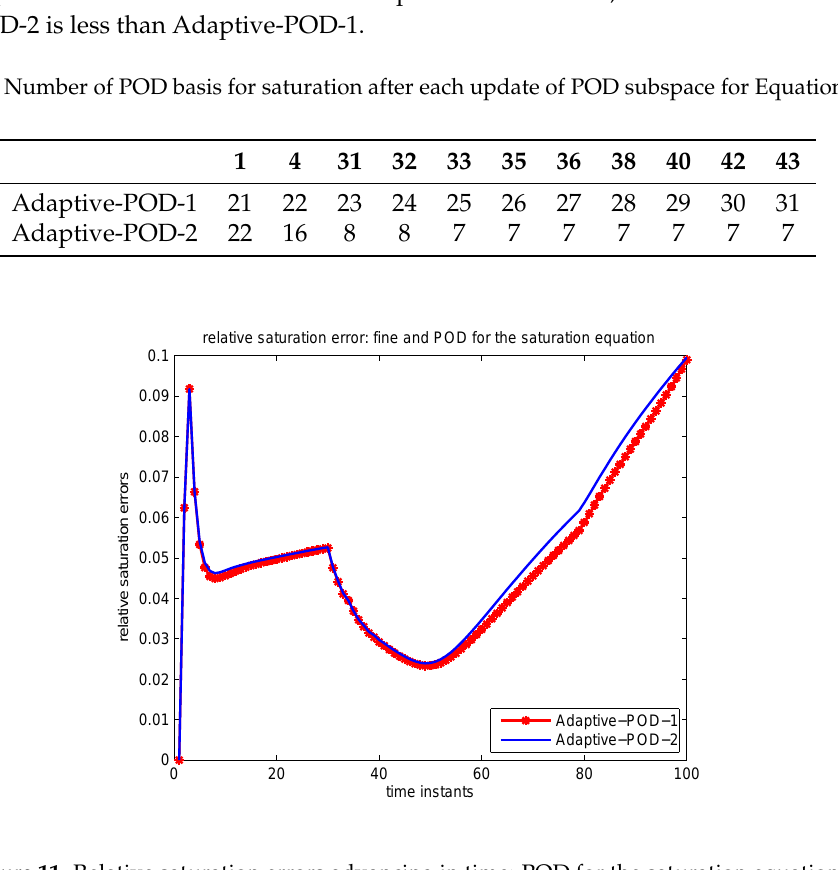
Figure 11. Relative saturation errors advancing in time: POD for the saturation